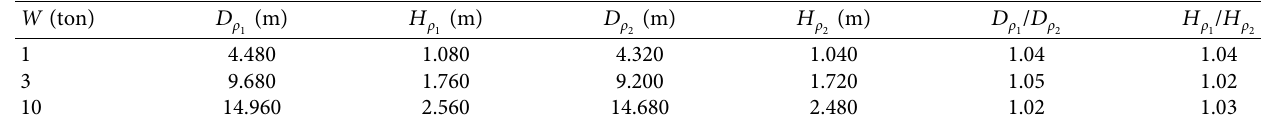
Table 6: Crater dimensions according to the sand and gravel density.